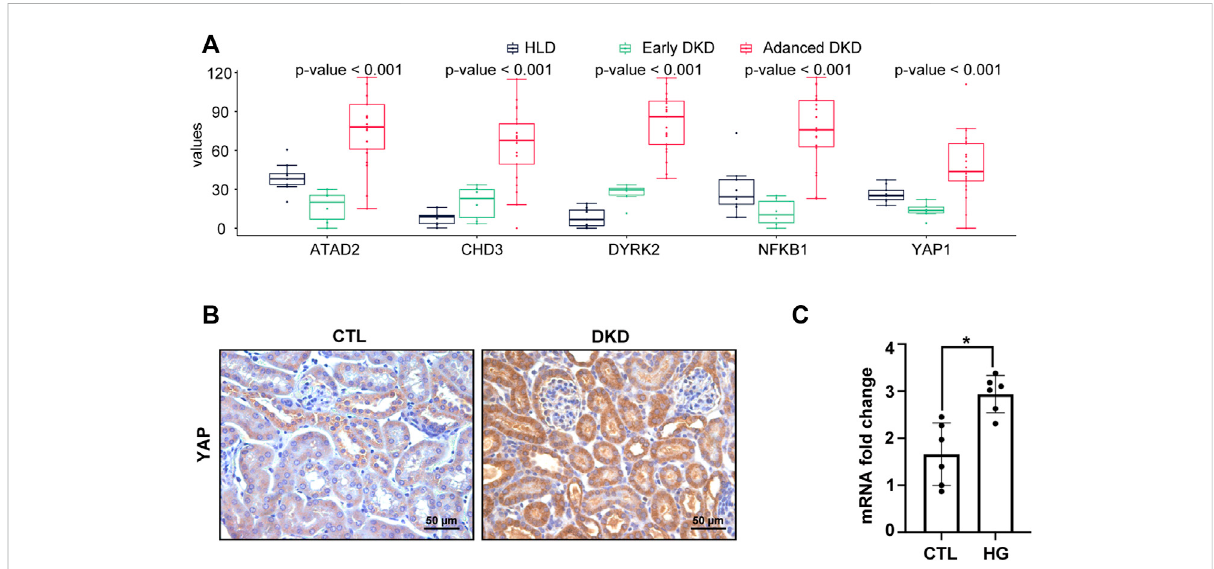
FIGURE 6 YAP1 was increased in advanced stage DKD samples, high glucose treated HK-2 cells, and mice kidney of diabetic kidney disease. (A) The expression patterns of hub genes among healthyliving donor, early stage DKD, and advancedstage DKD samples. (B) Representative IHC staining of YAP1 on mice kidney section of diabetic kidney disease. (C) High glucose treatment increased the mRNA expression in HK-2 cells. For all graphs, results were expressed as mean ± SD of data from three experiments. * p < 0.05 versus control (CTL). CTL, control; HG, high glucose; HLD, healthy living donor; DKD, diabetic kidney disease.